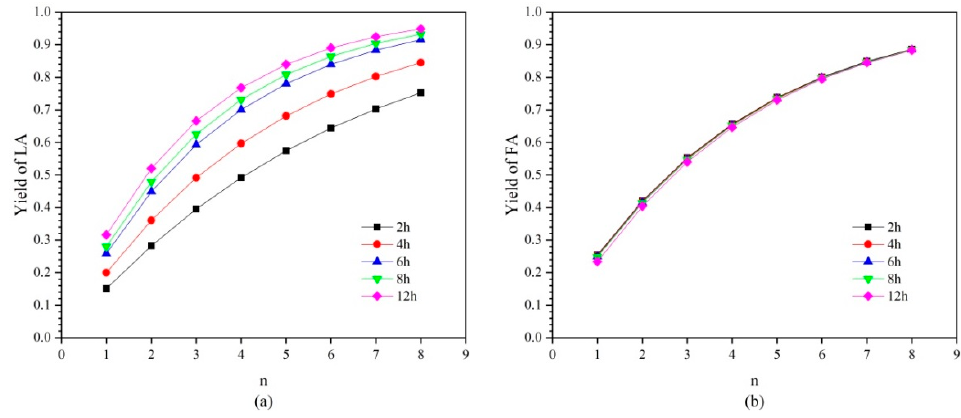
Figure 13. Influence of time in single-stage reaction on yields of ( a ) LA and ( b ) FA. Effect of Single-Stage N-Octanol